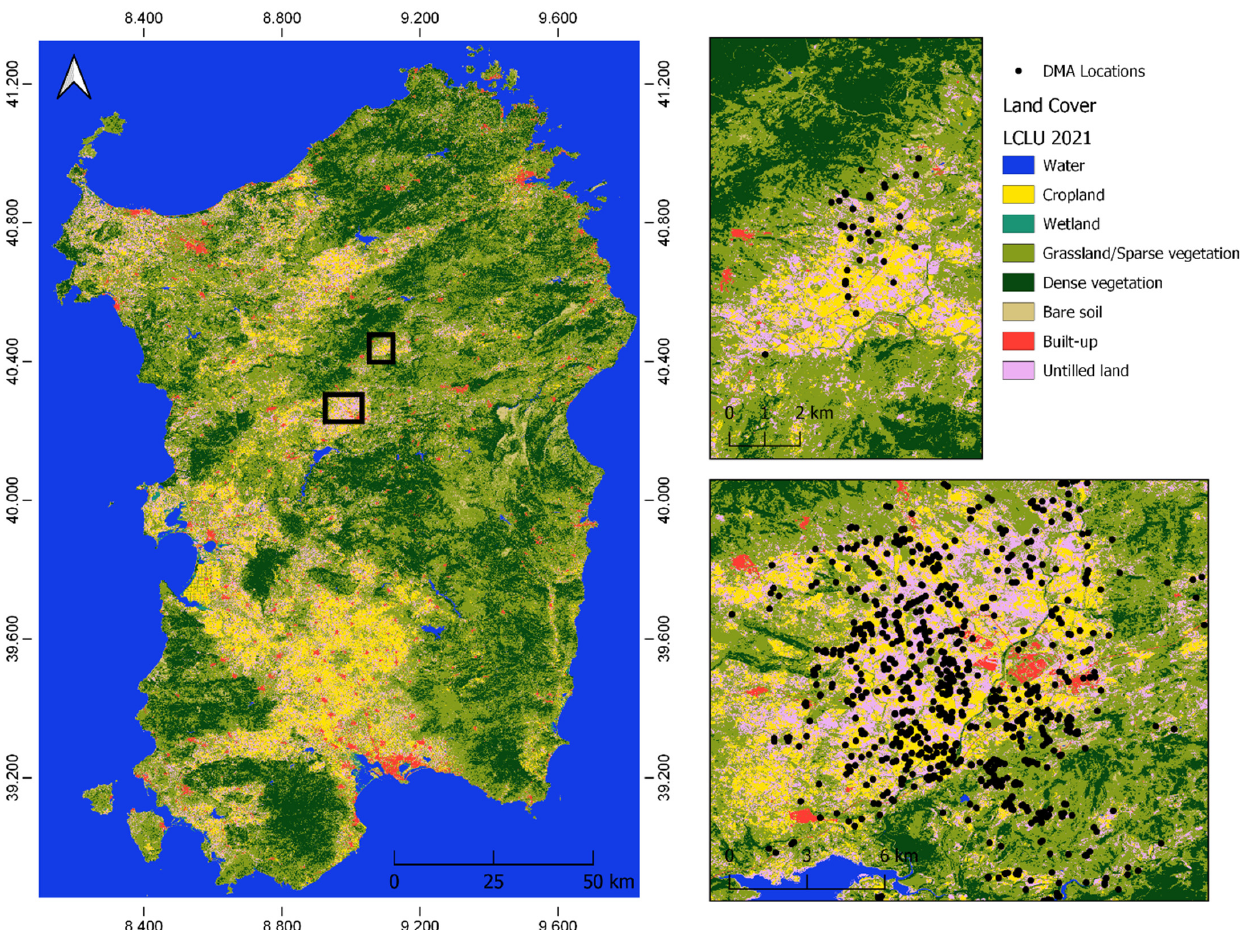
Figure 3. Land cover land use classification for 2021. Zoom areas for region of interest with majority of detected DMA